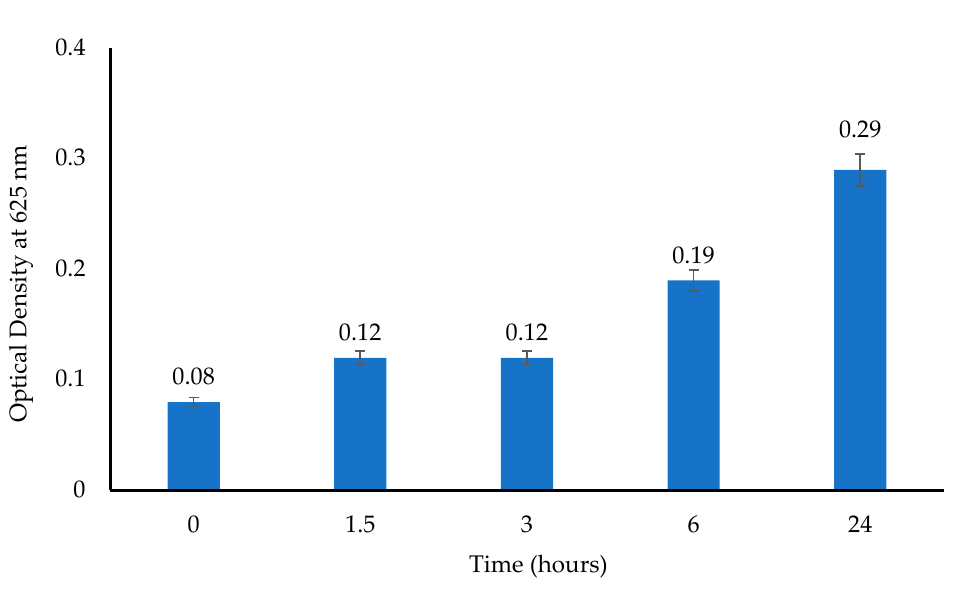
Figure 12. Bacterial growth (optical density) profiles over 24 h ( n = 3 ± SD).